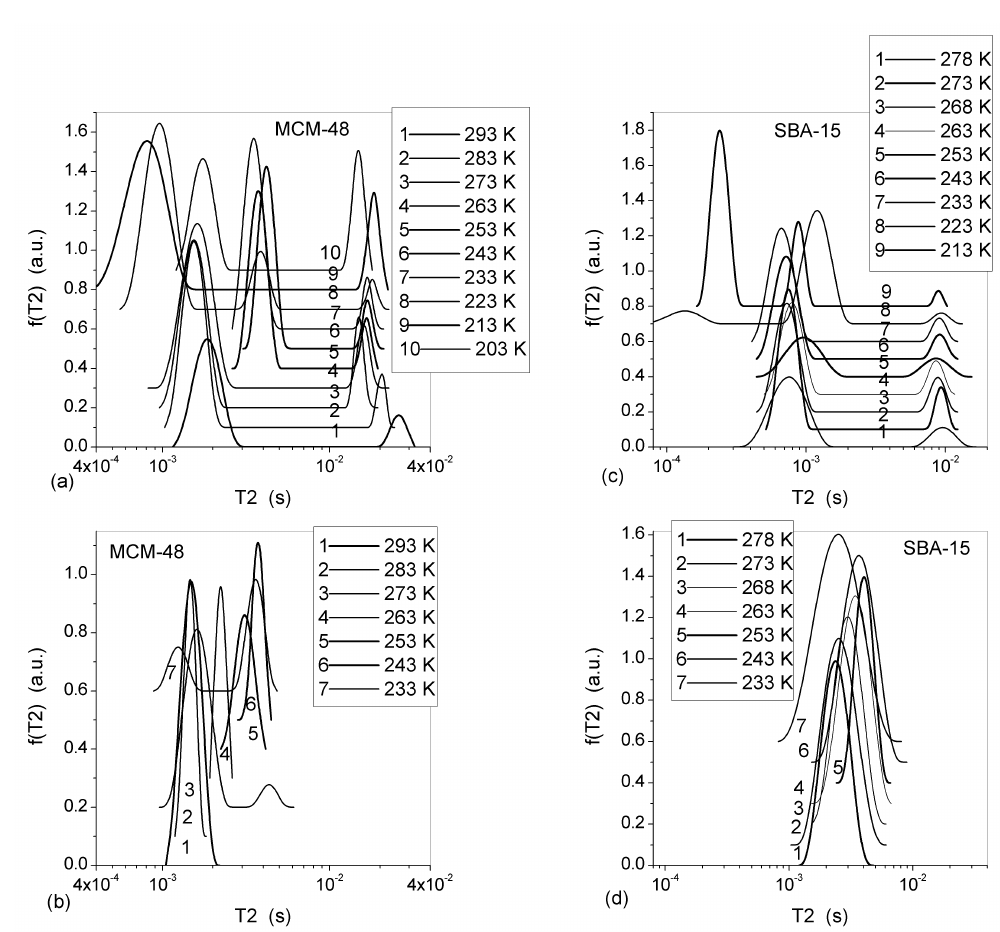
Fig. 5 Distribution functions of proton transverse relaxation time ( T 2) of (a) benzene and (b) water adsorbed onto MCM-48 as a mixture with C = 0.2 ml/g); (c) benzene and (d) water adsorbed onto SBA-15 as a mixture at h = 0.16 ml/g and b = 0.13